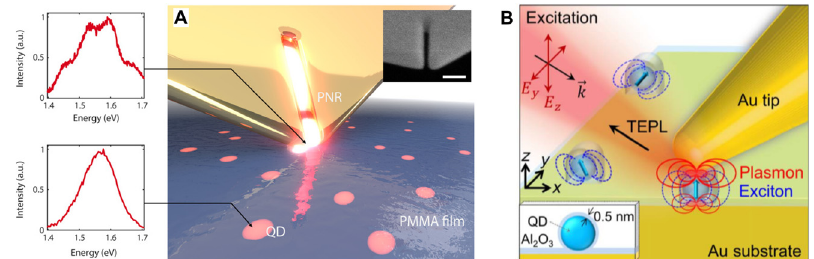
Figure 7: Tip-enhanced photoluminescence spectroscopy experiments for single quantum dots in the strong coupling regime demonstrated by two different groups. (A) Illustration of an experiment with fabricated plasmonicnanoresonator(PNR)andmeasured far-field and near-field PL spectra of